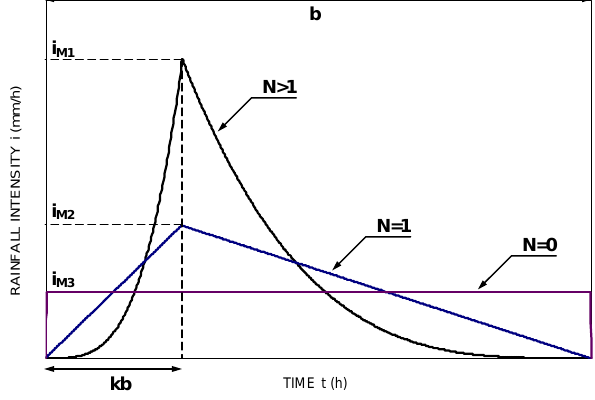
Fig. 3. Synthetic storm shape depending on